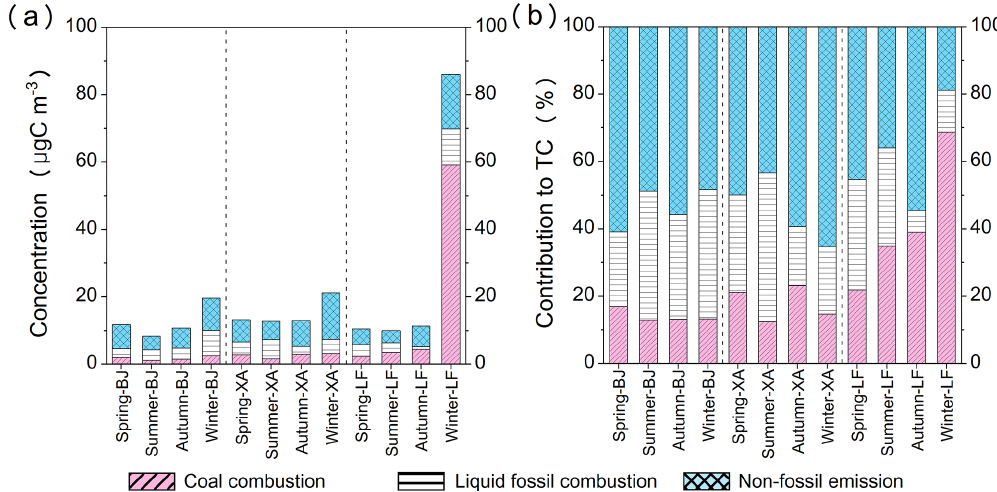
Figure 7. Mass concentrations (µgCm − 3 ) (a) and percentage (b) of coal combustion, liquid fossil fuel, and non-fossil source emissions for carbonaceous aerosol samples in BJ, XA, and LF during different seasons.